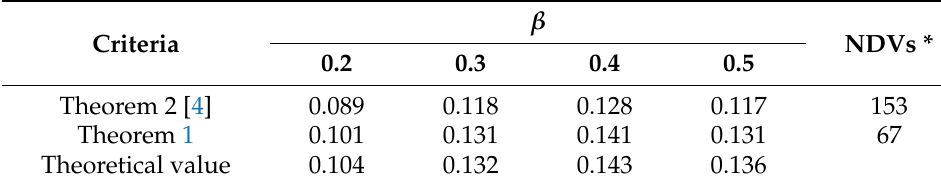
Figure 2. Variation graphs of dimensionless virtual stiffness versus dimensionless virtual damping. Table 1. The maximal admissible delay upper bounds of α